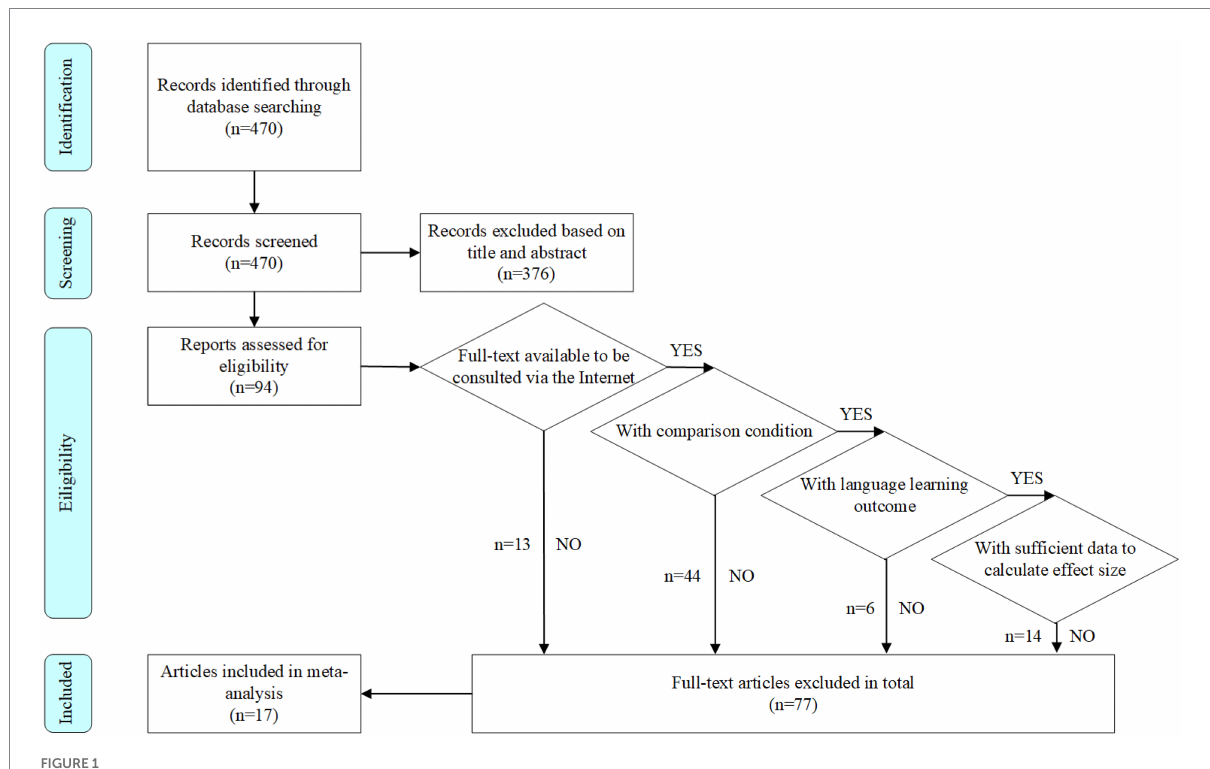
FIGURE 1 Flowchart for the article screening